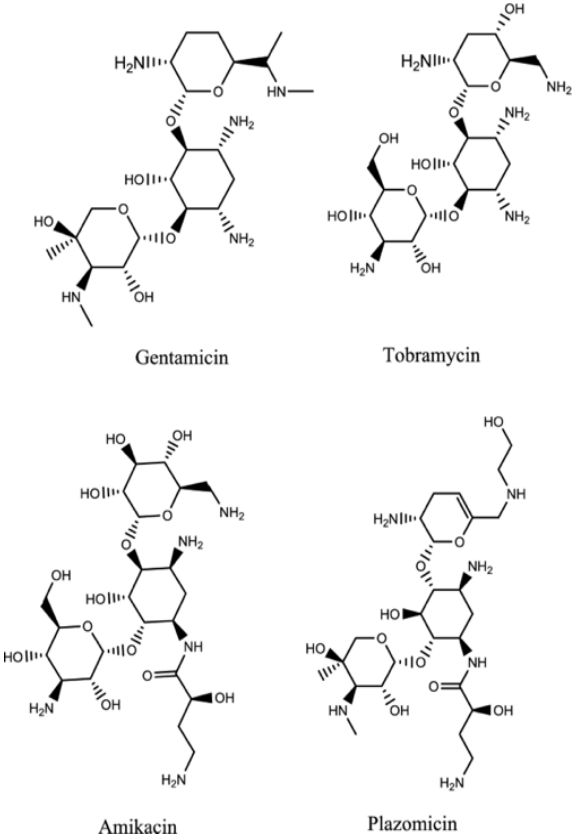
Figure 8. Group of 2-deoxystreptamines.